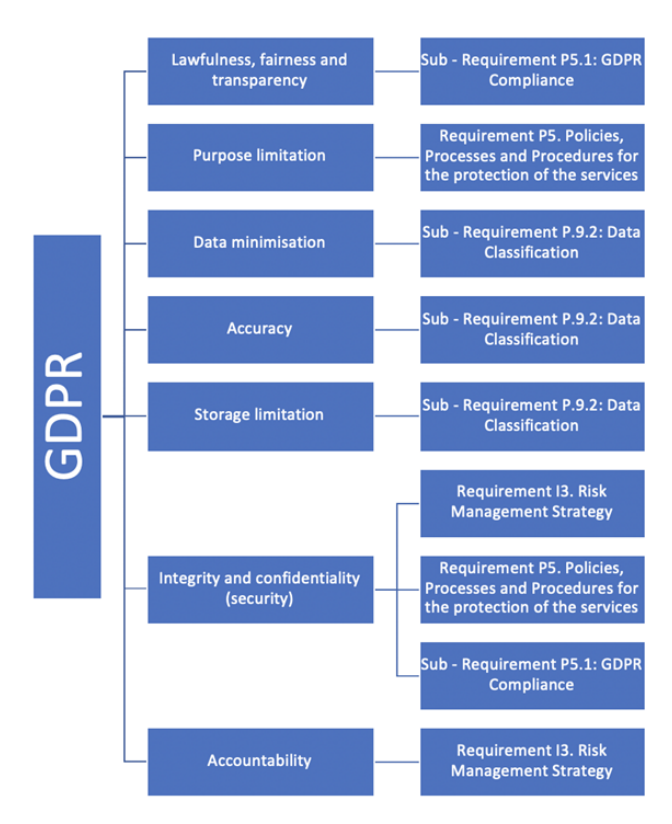
Figure 2. The proposed HCYMAF model in detail.